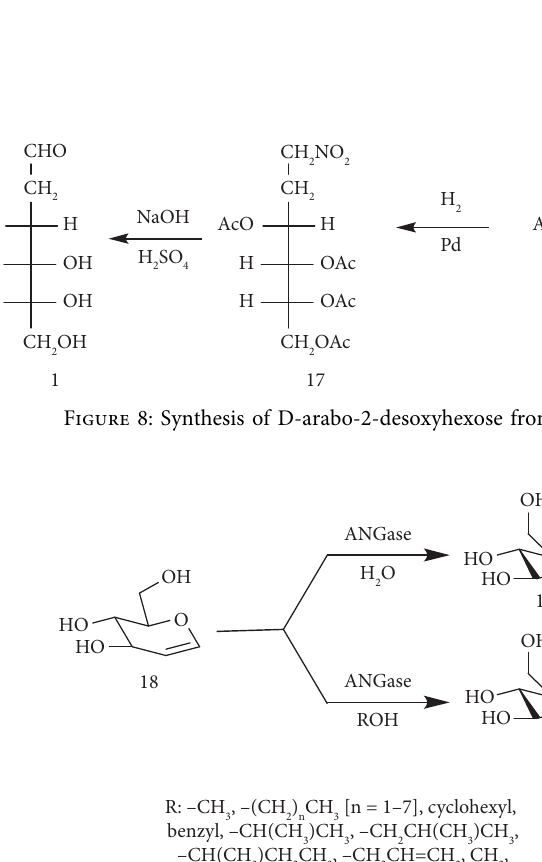
Figure 9: Synthesis of alkyl α -D-2-deoxyglucosides by using Aspergillus niger α